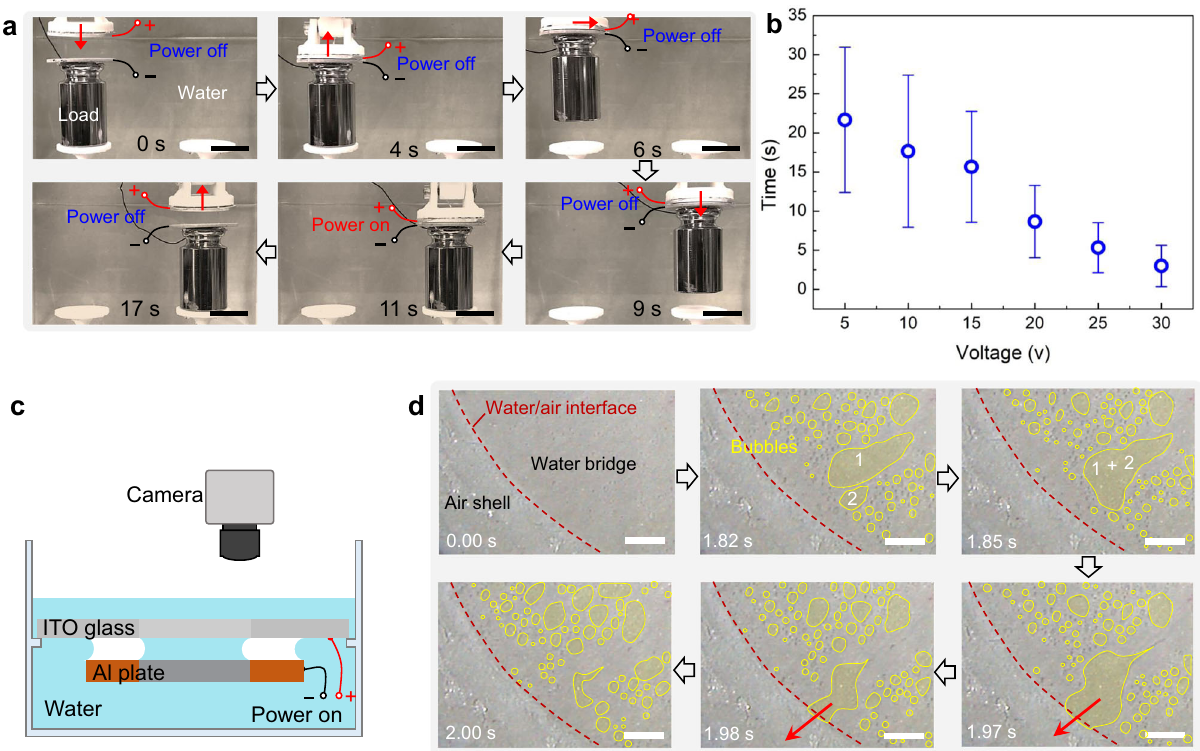
Fig. 4 | On-demand reversible underwater adhesion triggered by electricity. a Selectedsnapshotimagesshowingthefastandon-demandpick-upandreleaseof 200× g metal load under a DC voltage of 20V. Here, the scale bar is 2cm. b The response time of reversible underwater adhesion is regulated by the applied vol- tage. The error bars are the standard deviations of fi ve measurements. c The